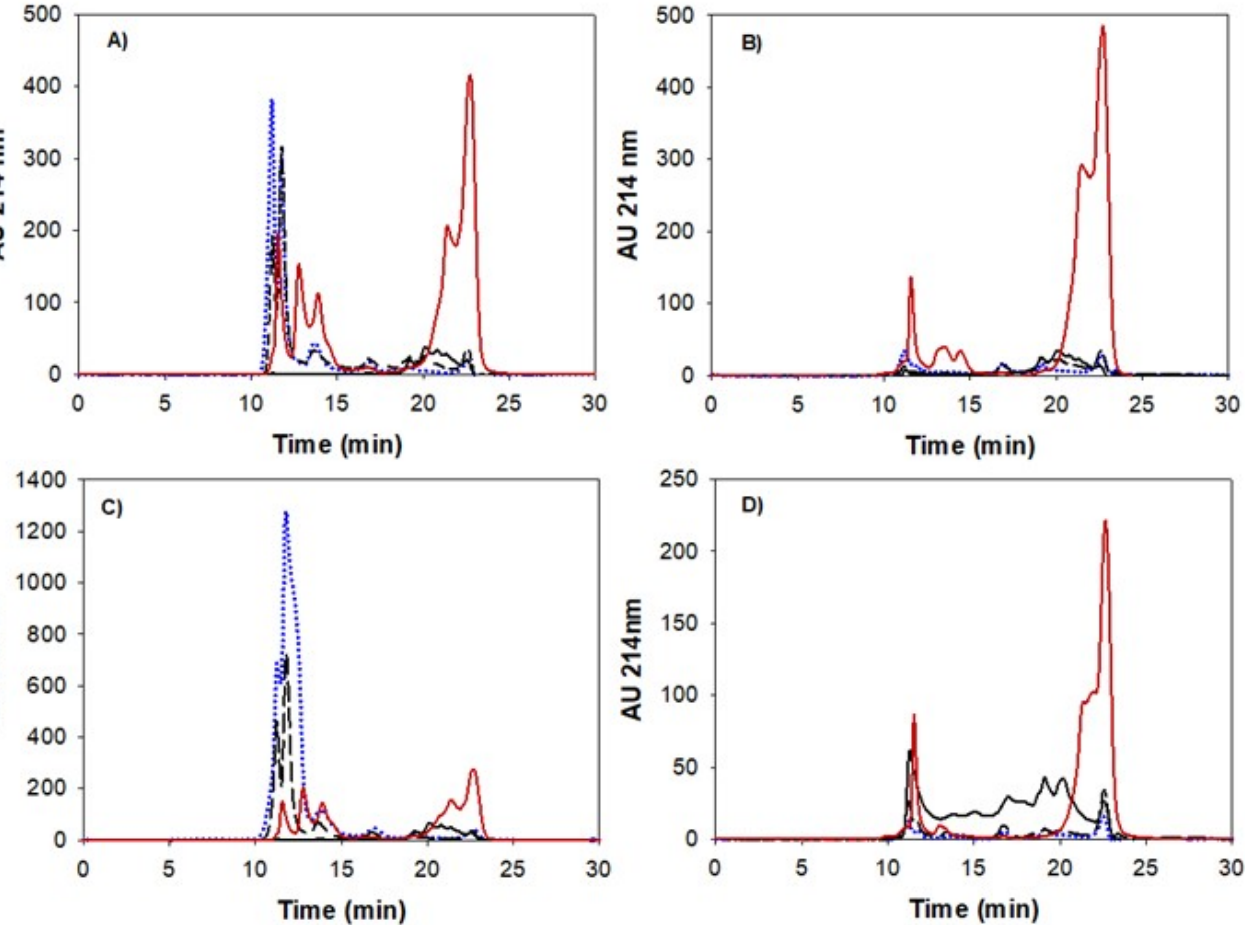
Figure 4. Representative elution patterns for supernatants of the digestates at G1, G3, G5 and I1 analyzed by size exclusion chromatography (see methods) for potato protein isolates: suspension ( A ), gel ( B ), foam ( C ), heated foam ( D ). Standard peaks elution: 100 kDa–10.6 min, 30 kDa–13 min, 1 kDa–19 min. G1 (dotted blue line), G3 (broken line), G5 (continuous black line) and intestinal, corresponding to G1 (red line).